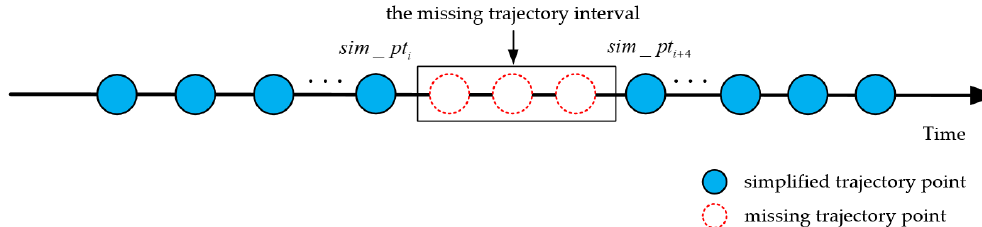
Figure 4. Simplified trajectory with missing trajectory points.